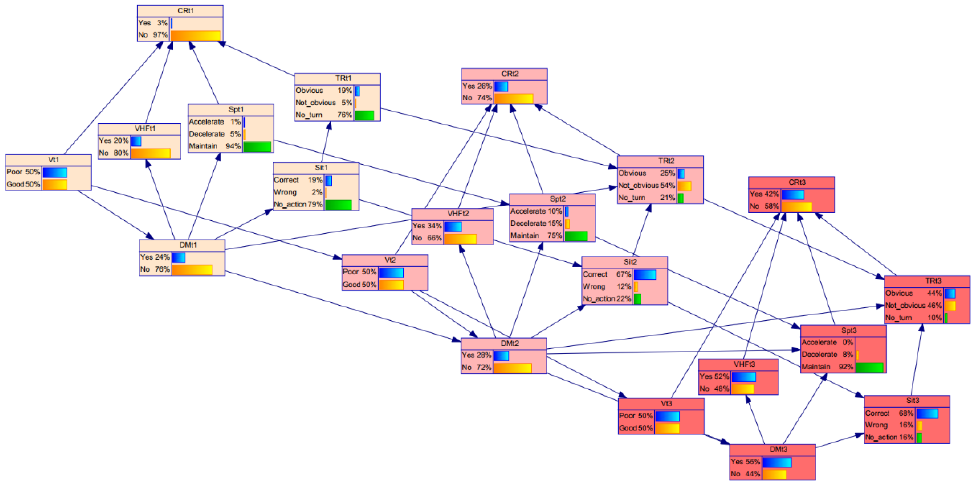
Figure 7. Posterior probability distribution of the DBN model.